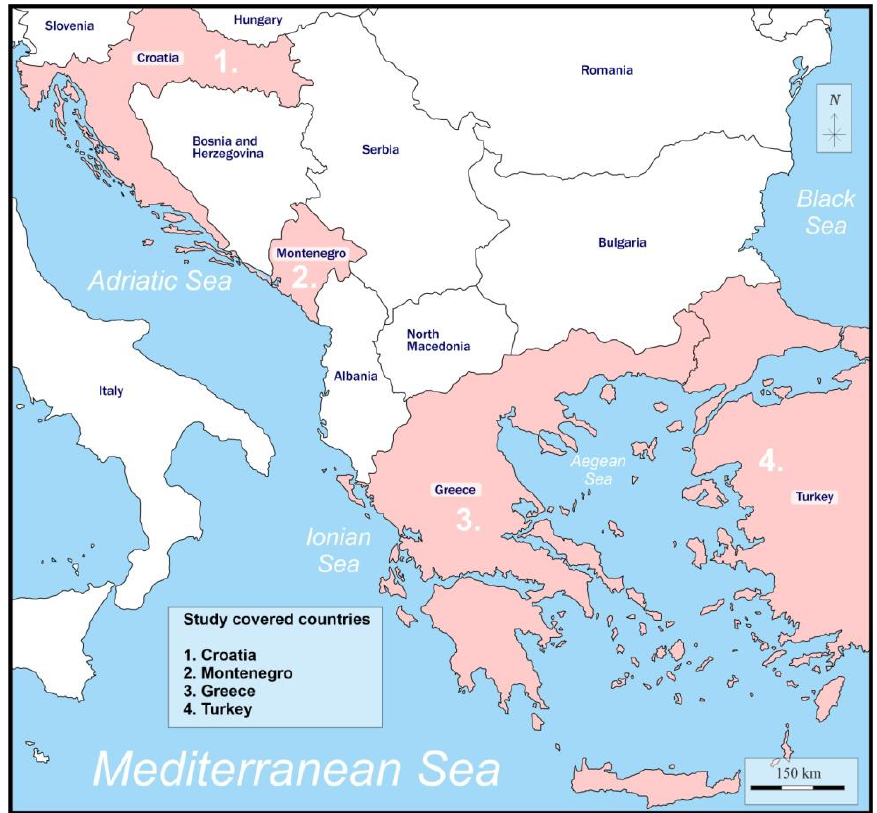
Figure 1. Study covered countries.